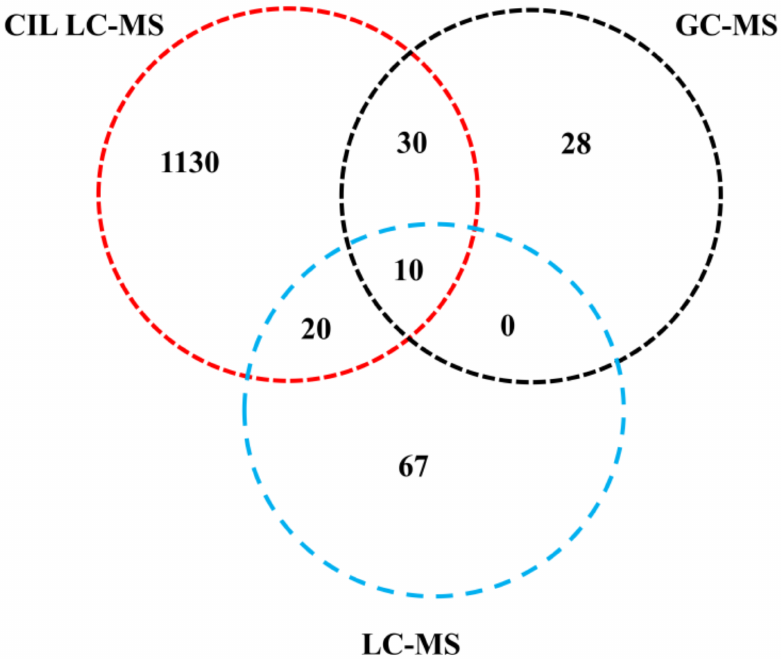
Figure 1. General information on identified metabolites using CIL LC-MS, label-free LC-MS, and GC-MS,